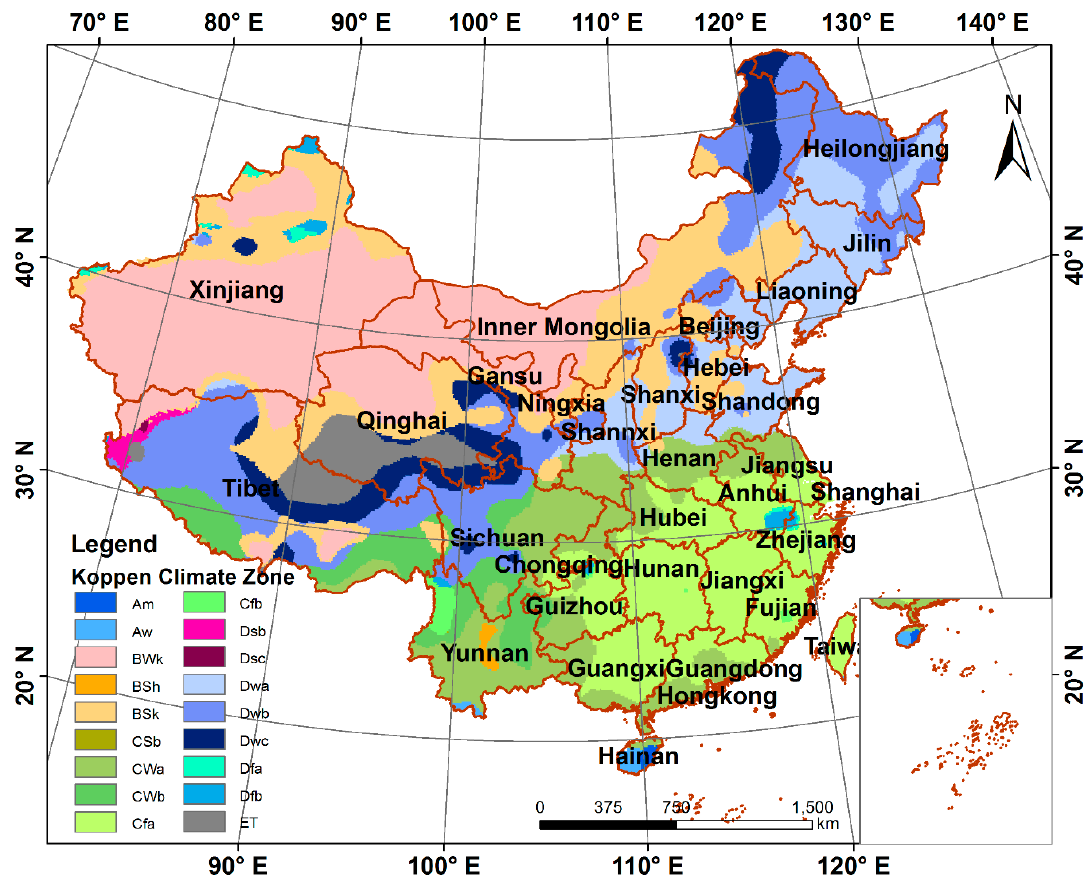
Figure 2. Koppen–Geiger climate classification over China.